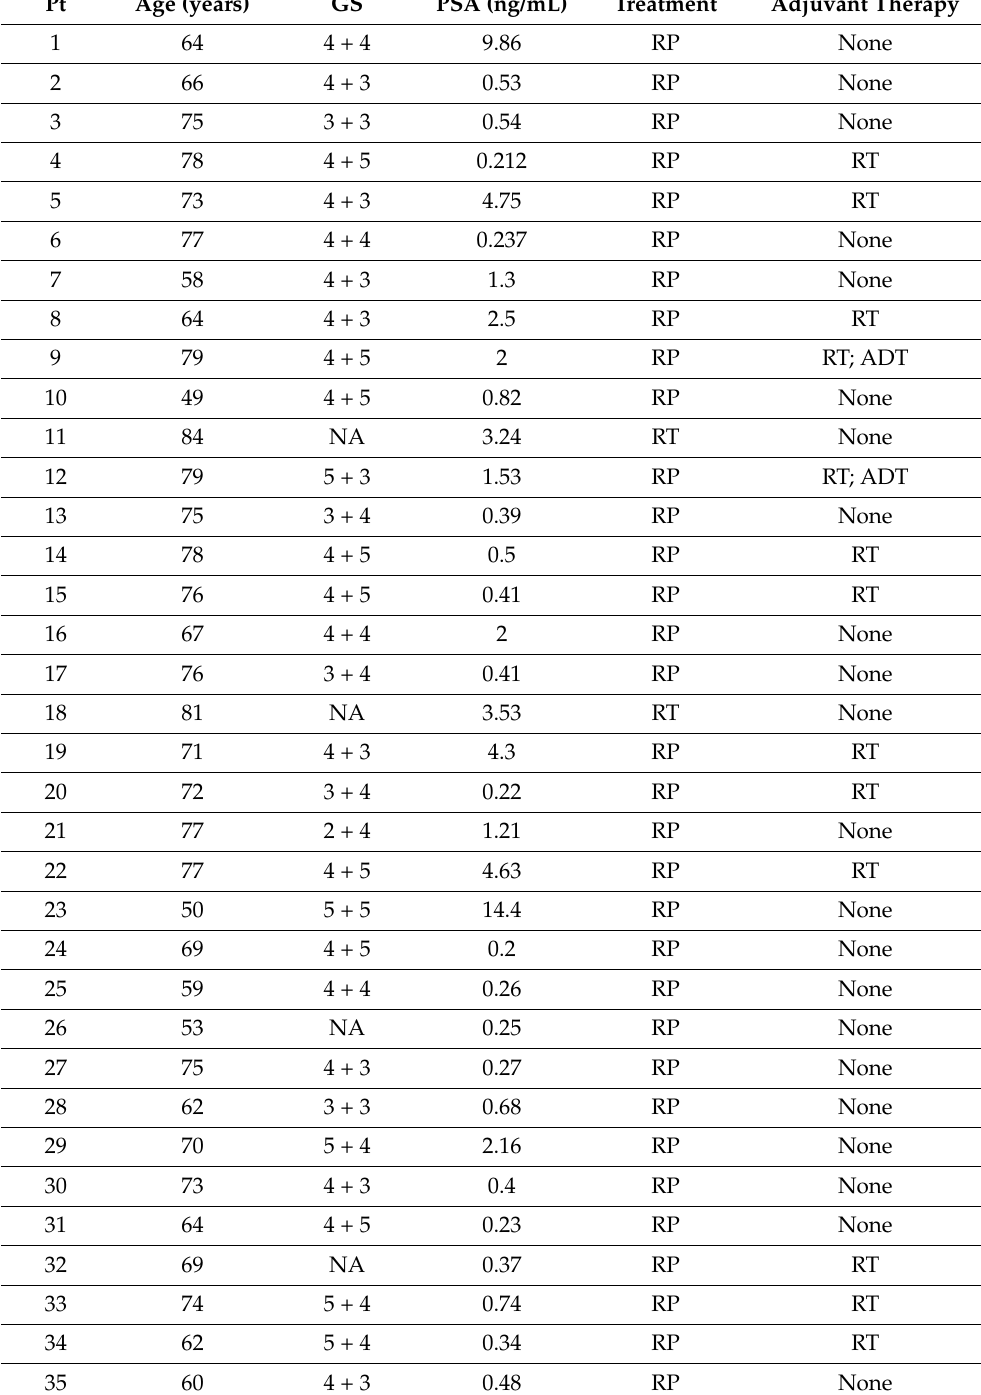
Table 1. Patients’